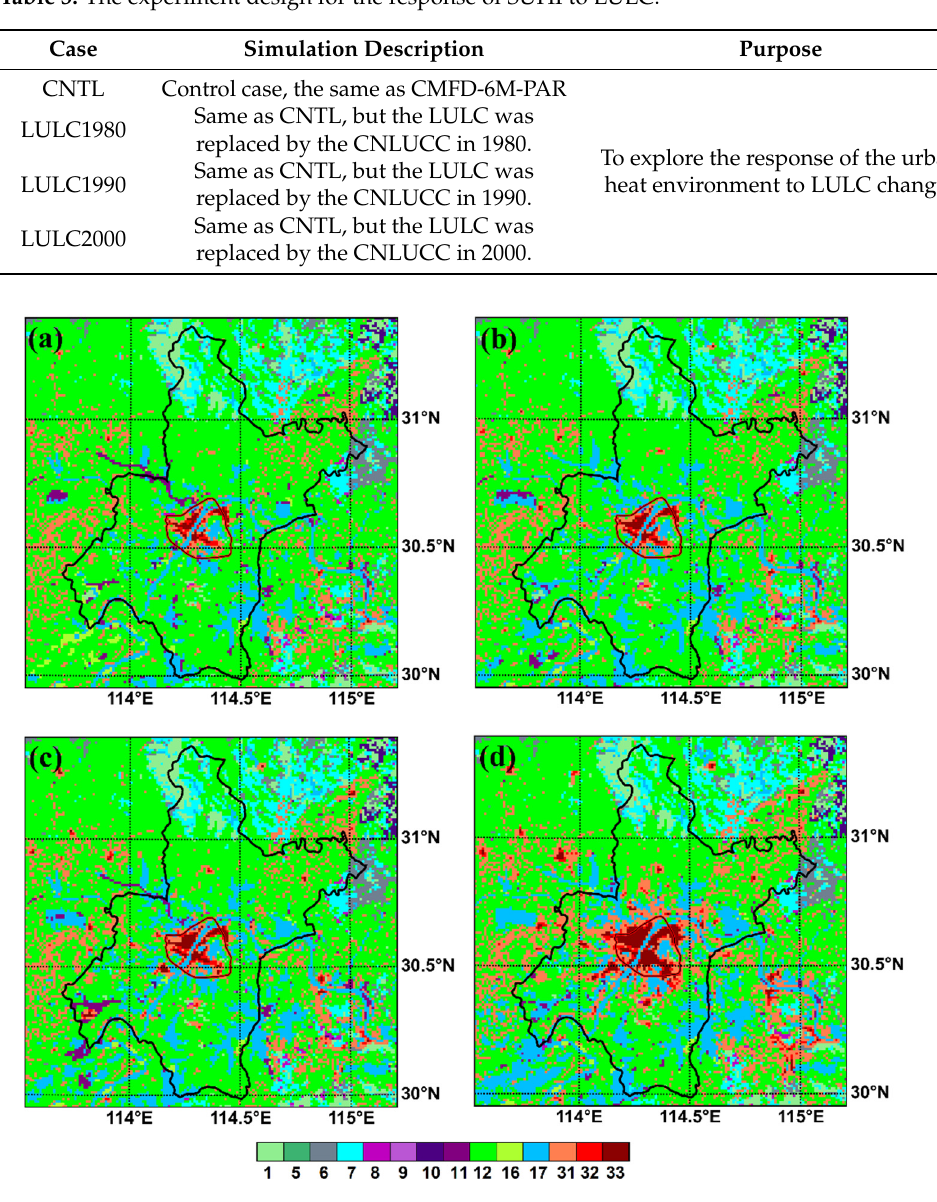
Figure 2. The land use and land cover in different periods of Wuhan: ( a ) LULC1980; ( b )